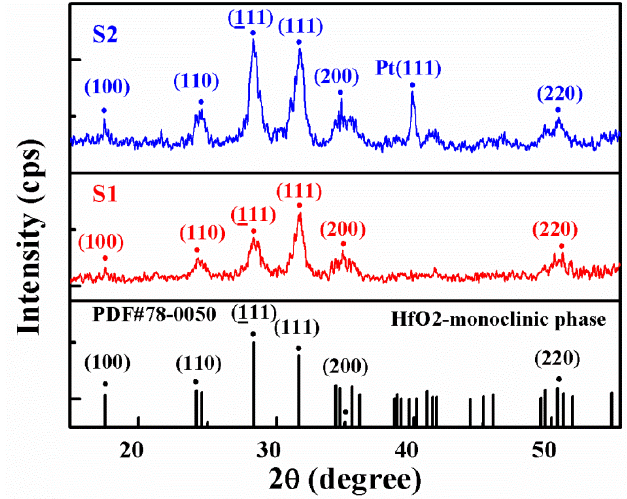
Figure 3. Grazing-incidence X-ray diffraction patterns of HfO 2 thin films in S1 and S2.